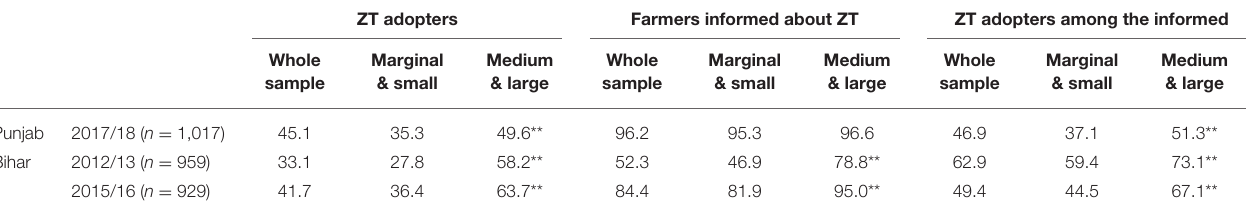
TABLE 2 | ZT adoption (% share of households) among sample wheat farmers in Punjab and Bihar.